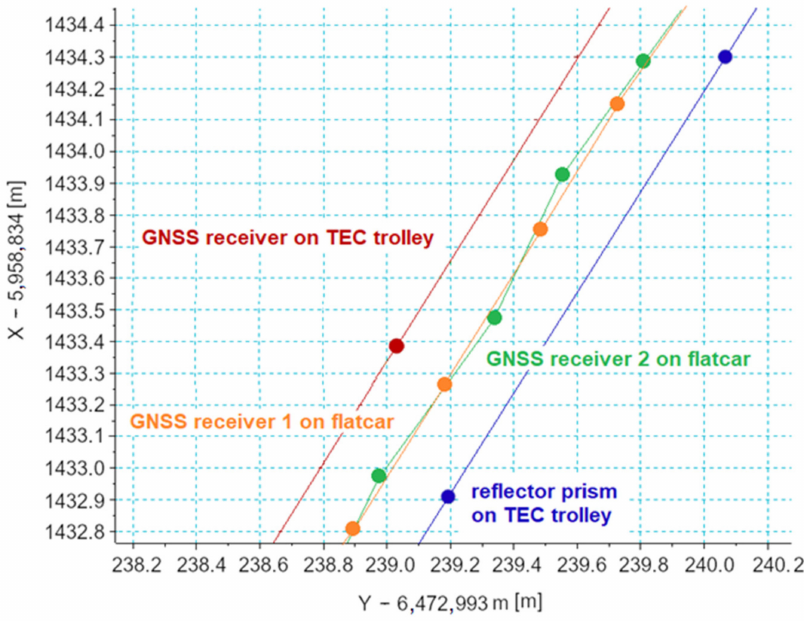
Figure 9. Horizontal differences between co-ordinates recorded using different measurement